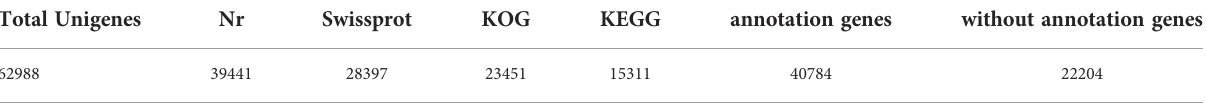
TABLE 1 Annotation statistics of four